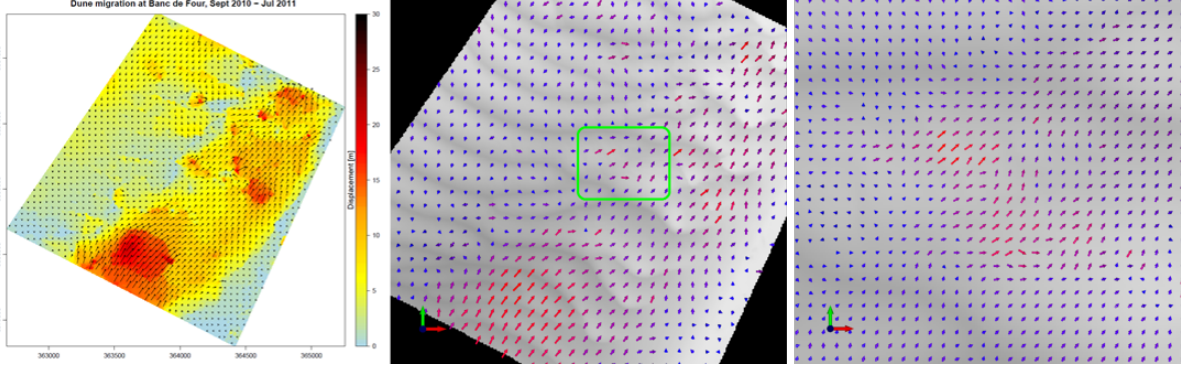
Figure 4: Interactive dynamic glyphs: Usual static result image (left), using interactive glyphs (middle), zoomed in view using glyphs